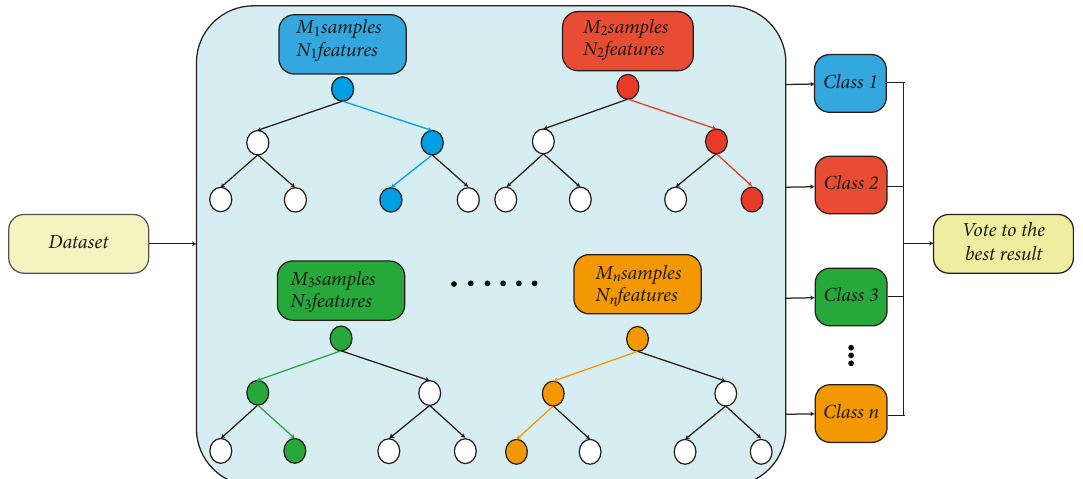
Figure 1: Flow of random-forest-based feature selection.